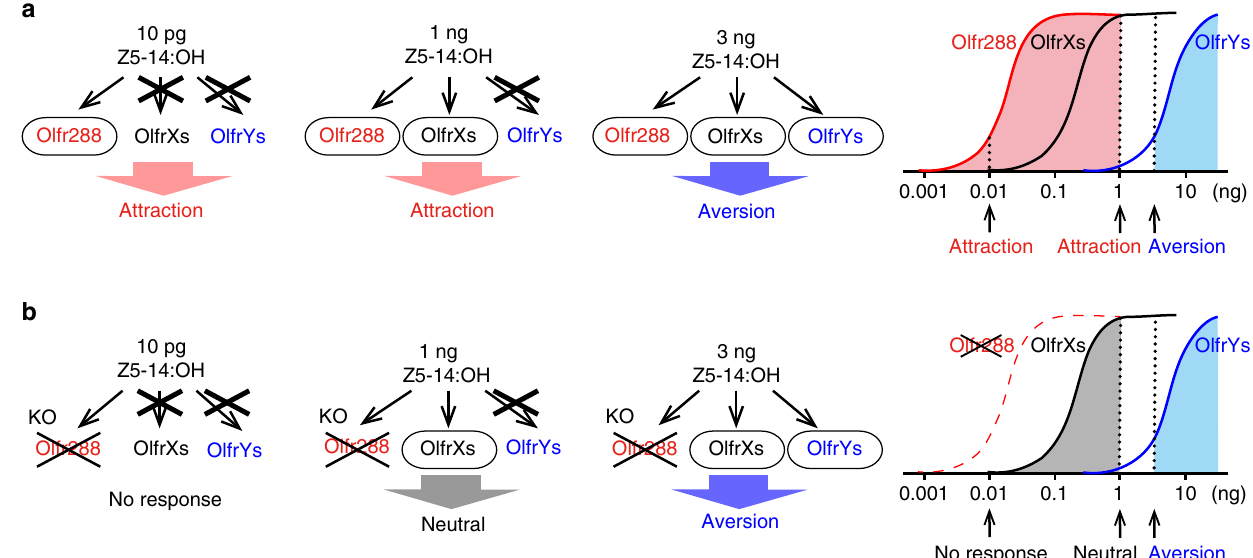
Fig. 5 A receptor-based model for concentration-dependent switching from attraction to aversion to Z5 – 14:OH. Behavioral data of wild-type mice ( a ) and Olfr288 knockout mice ( b ) in response to various amounts of Z5 – 14:OH (10 pg, 1, 3 ng) are consistent with a model ( a , b right) in which activation of Olfr288 (red) and OlfrY(s) (blue) are involved in attraction and aversion to Z5 – 14:OH, respectively; activation of OlfrX(s) are